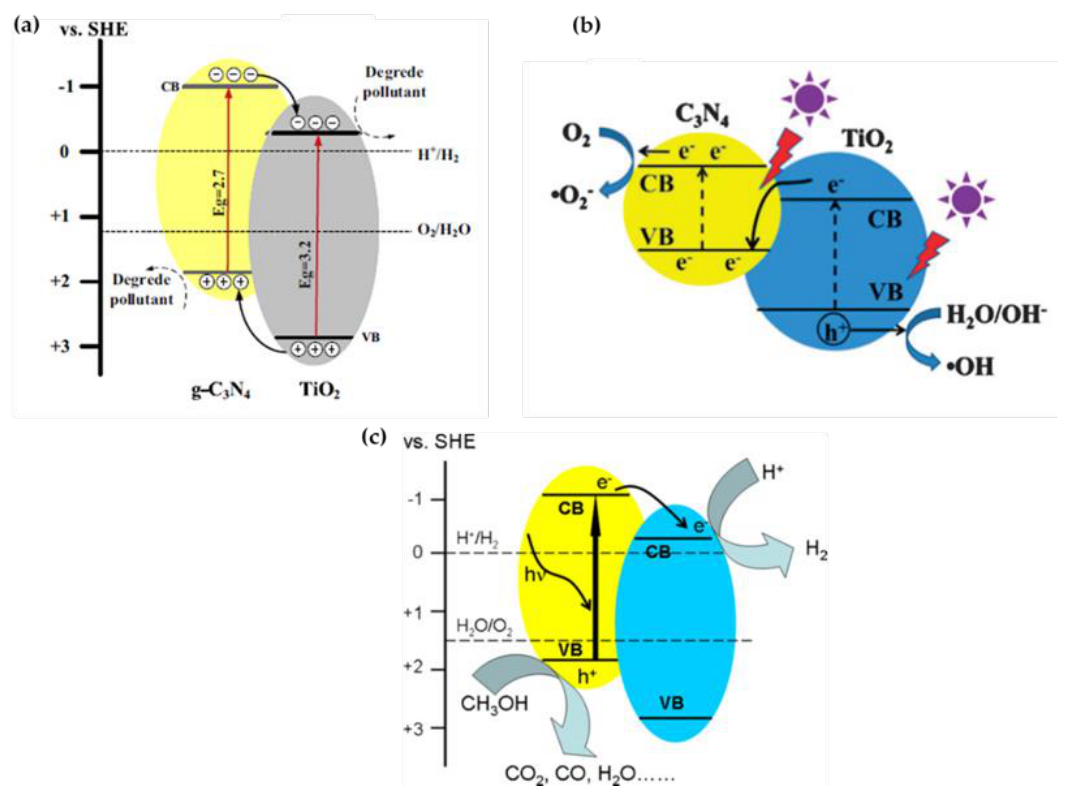
Figure 6. The photocatalytic mechanism of the TiO 2 /g-C 3 N 4 heterojunction: Type II ( a ) (reprinted with permission from [82]; Copyright 2012, Elsevier), and Z-scheme ( b ) (reprinted with permission from [91]; Copyright 2013, RSC Publishing) under UV/visible light irradiation; electron transfer pathway under exclusive visible light irradiation ( c ). Reprinted with permission from [81]; Copyright 2011, Elsevier.